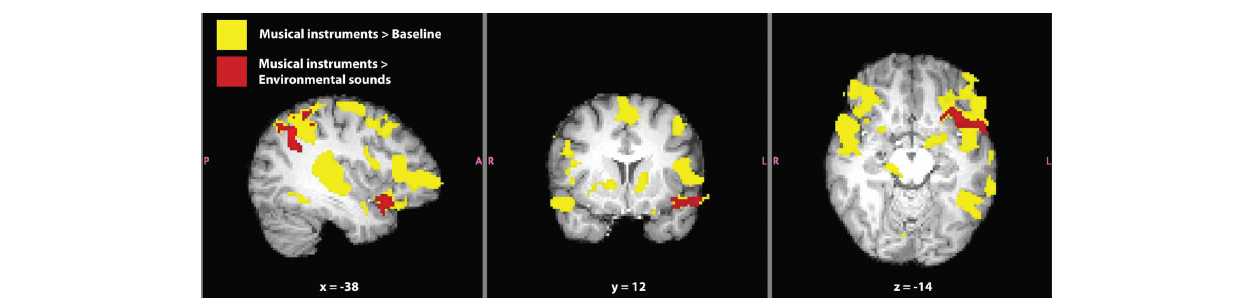
FIGURE 6 | Verbal and non-verbal language localizer for synesthete SC. Significant activation for the contrasts musical instruments > baseline (yellow) and musical instruments > environmental sounds (red) are shown. The contrast musical instruments > environmental sounds represents a